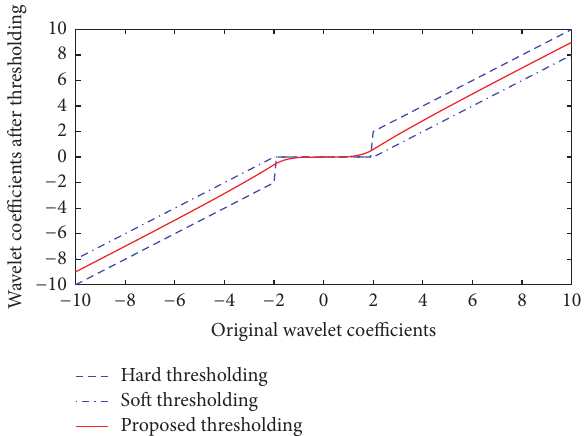
Figure 2: Comparison with hard and soft thresholding functions.